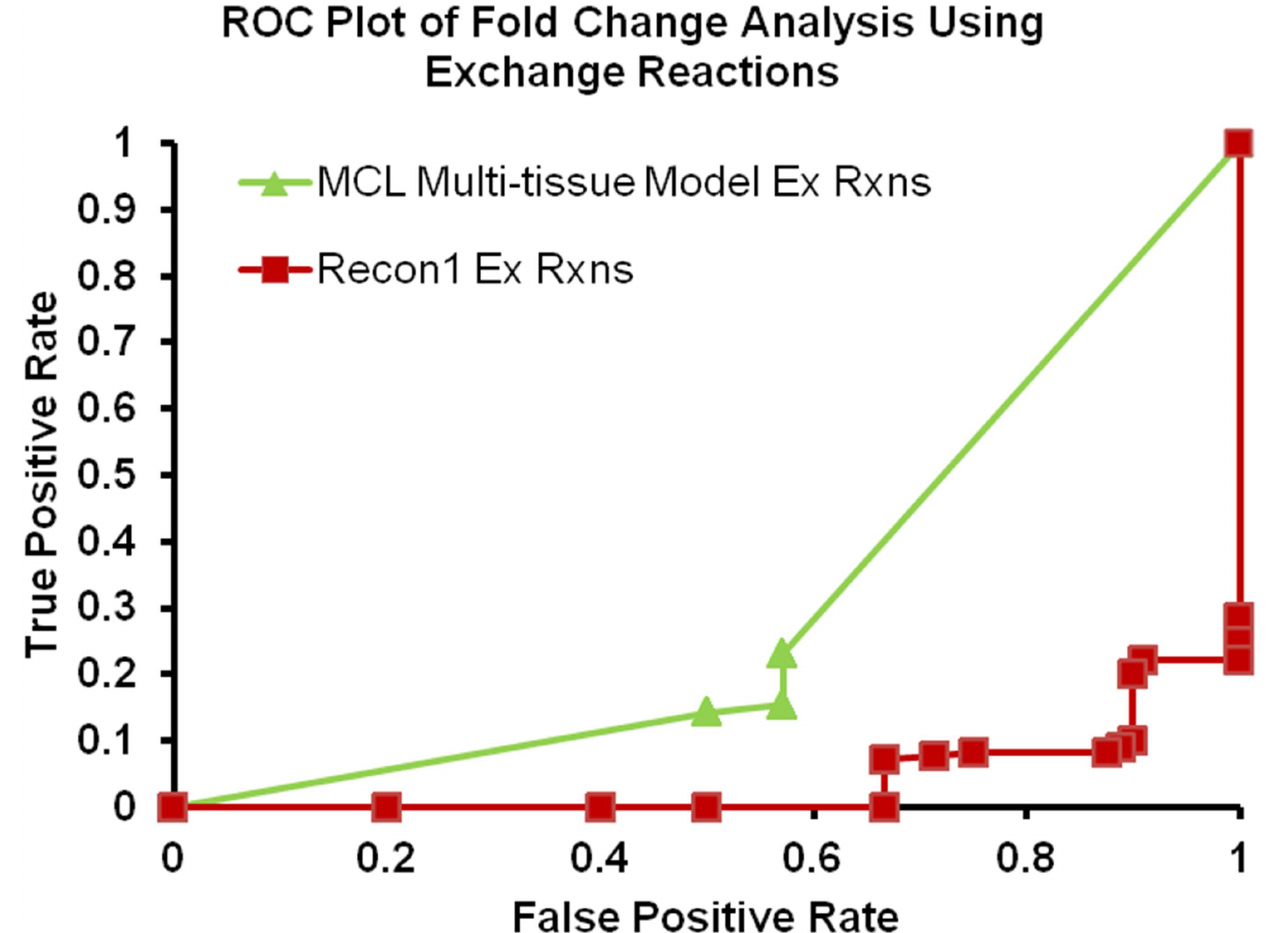
Figure 4. ROC plot for exchange flux changes using Zucker fatty rat data. ROC plot of the results generated by comparing the exchange flux changes determined by applying diabetic and wild-type gene expression data to the MCL multi-tissue model and Recon1 to available literature data on amino acid concentration changes in the blood/plasma.